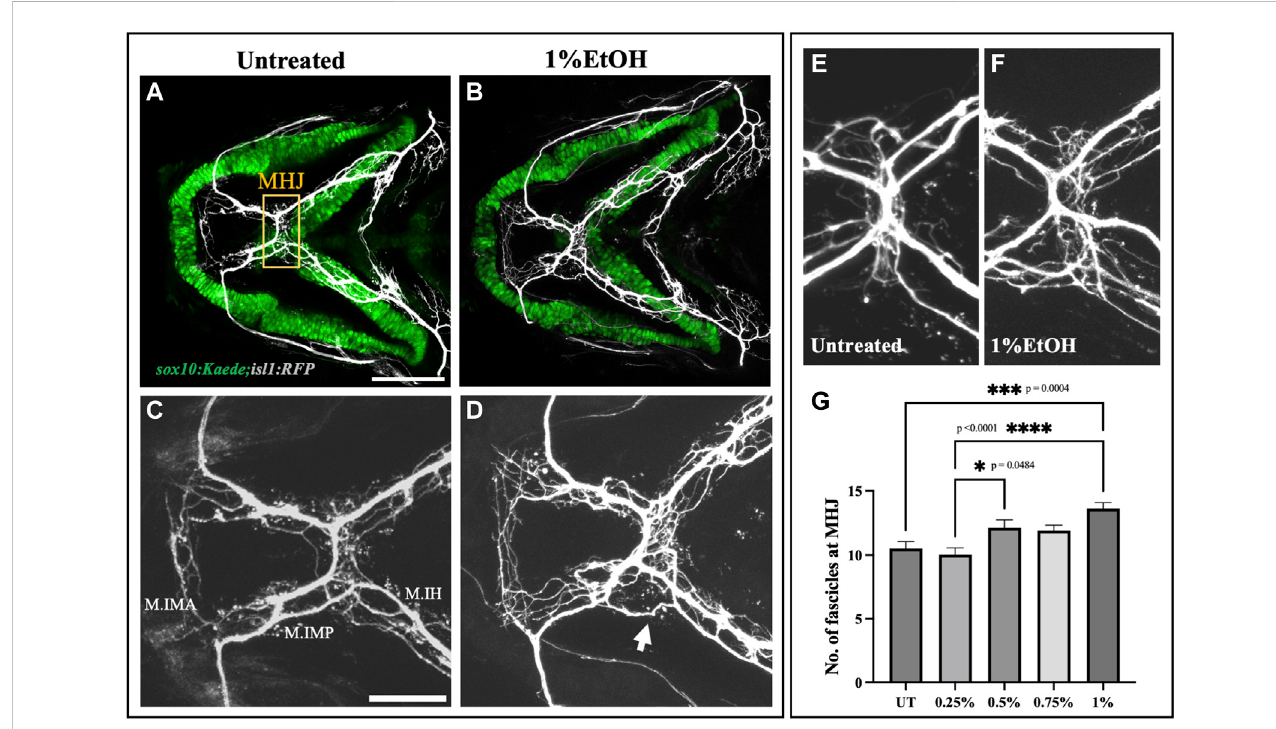
FIGURE 7 Ethanolinducescranialnervedefasciculation (A,B) Untreatedandethanol-exposed sox10:Kaede;isl1:RFP fi sh.Scalebar=100 um. (C,D) Magni fi edview of motor innervations in Intermandibularis anterior (M.IMA), Intermandibularis posterior (M.IMP) and Interhyoideus muscles (M.IH) in untreated and ethanol- exposed fi sh. Scale bar = 50 um. Arrow in D indicates defasciculated exons around MHJ (mylohyoid junction). (E, F) High-resolution images of MHJ region in untreated and ethanol-exposed fi sh. (G) Number of fascicles at MHJ signi fi cantly increase in fi sh exposed to 1% ethanol.* = p < 0.05; *** = p < 0.001; **** = p <